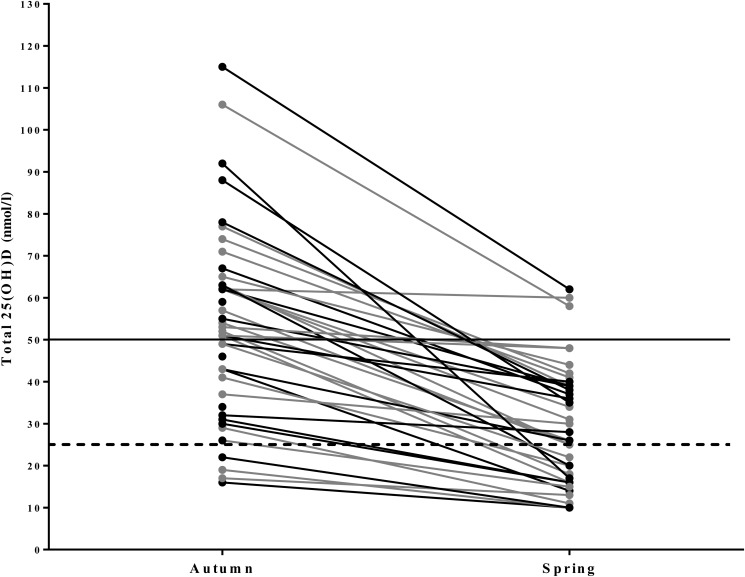
Line graph illustrating the individual variation of 25-hydroxyvitamin D (25(OH)D) concentrations in university-level athletes assessed in autumn (n 47) and spring (n 47). 25(OH)D statuses of <25 nmol/l are considered deficient (----). 25(OH)D statuses of >50 nmol/l are considered sufficient (–––). ●, Indoor athletes; ●, outdoor athletes.